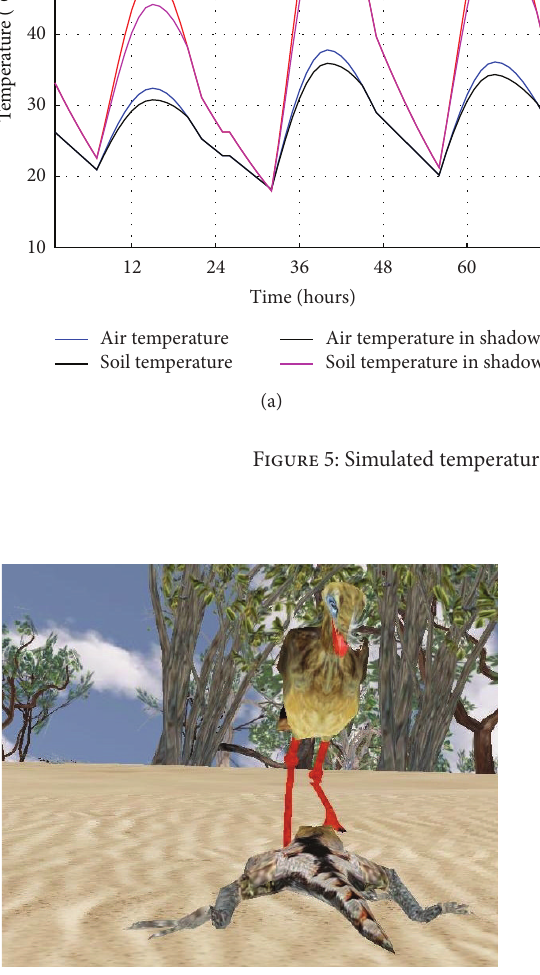
Figure 8: Male and female lizards close to the player’s lizard.